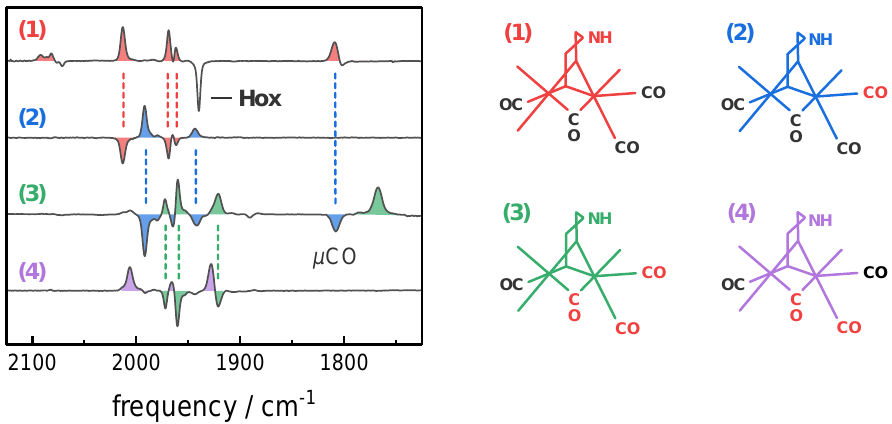
Figure 4. CO inhibition of Hox and preparation of Hox-CO isotopomers 1–4. Shown are in situ attenuated total reflection Fourier-transform infrared spectroscopy (ATR-FTIR) difference spectra of Chlamydomonas reinhardtii (HYDA1) in the CO/CN - frequency regime of the H-cluster (left panel) and corresponding diiron site structures with indicated 13 CO labeling patterns (right panel, 13 CO in red). Hox-CO species 1 is formed upon exposure of the oxidized enzyme (Hox) to 12 CO gas in the dark. The exposure of isotopomer 1 to 13 CO gas in the dark yields species 2, further illumination with white light under 13 CO results in isotopomer 3. The exposure of isotopomer 3 to 12 CO in the dark results in the formation of isotopomer 4. Note that the frequencies of the CN - ligands are barely affected by 13 CO isotope editing, while the Hox → Hox-CO conversion is associated with difference signals in the CN - regime as well (2050–2100 cm − 1 ).